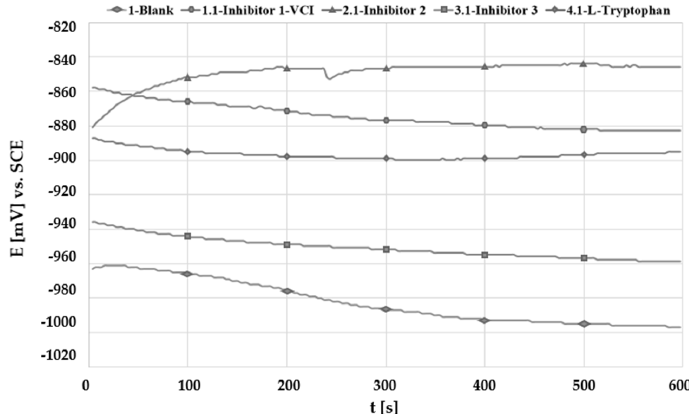
Figure 1. Corrosion potential diagram with and without the addition of inhibitors in fresh water.